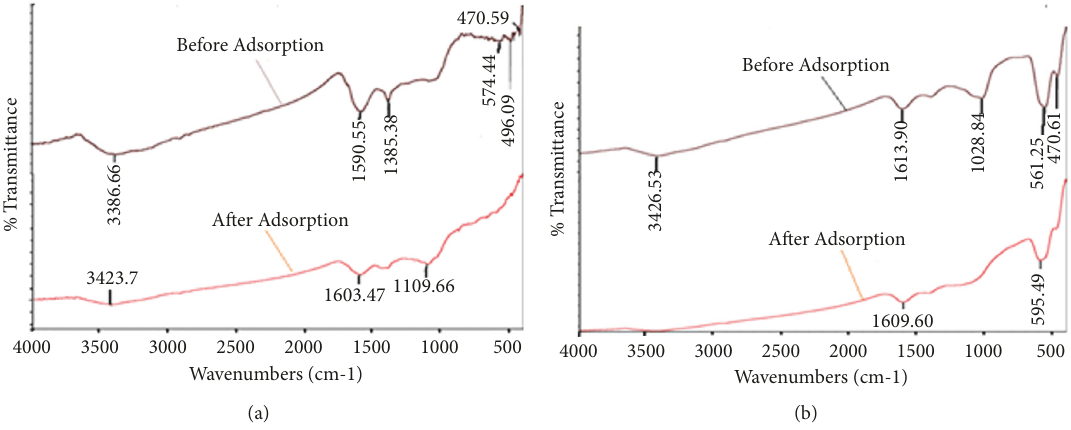
Figure 1: FTIR spectrum for adsorbed and unadsorbed biochars: (a) EC, (b) Fe 2 O 3 EC.